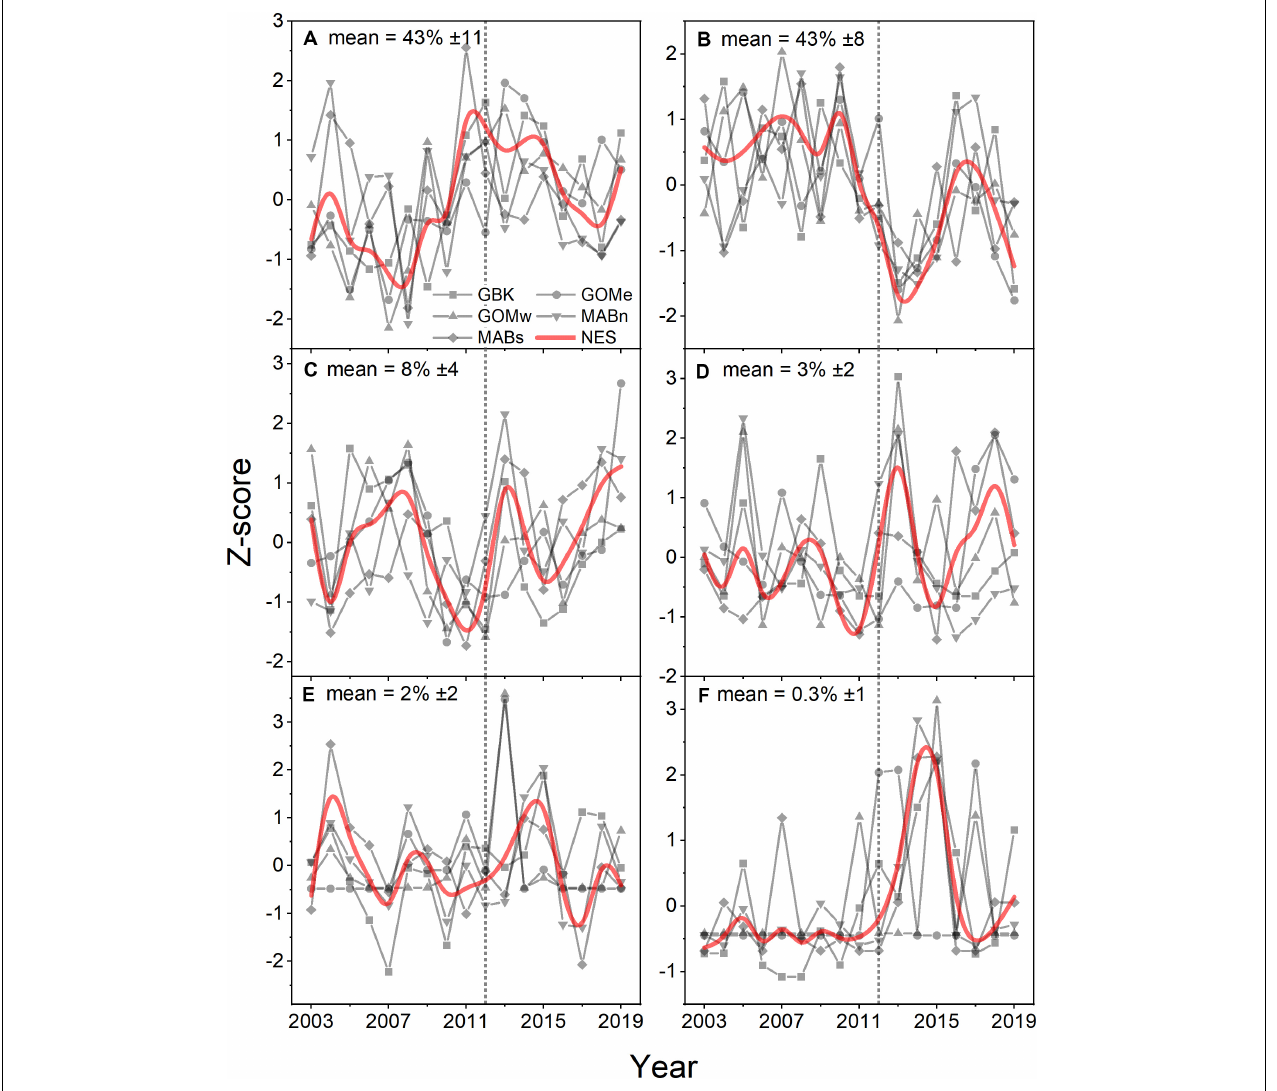
FIGURE 6 | Z-score of percentage area where Nanoeucaryotes (A) , Diatoms (B) , Phaeocystis-like (C) , Coccolithophorids (D) , Synechococcus (E) , Prochloroccocus (F) were the dominant PFT for the Northeast Shelf (NES) and NES subareas (NES, GBK, GOMe, GOMw, MABn, and MABs). The mean percentage for each PFT shown in the panel title with ± 1 SD; the NES time series is shown as a b-spline; 2012 is highlighted with vertical dotted